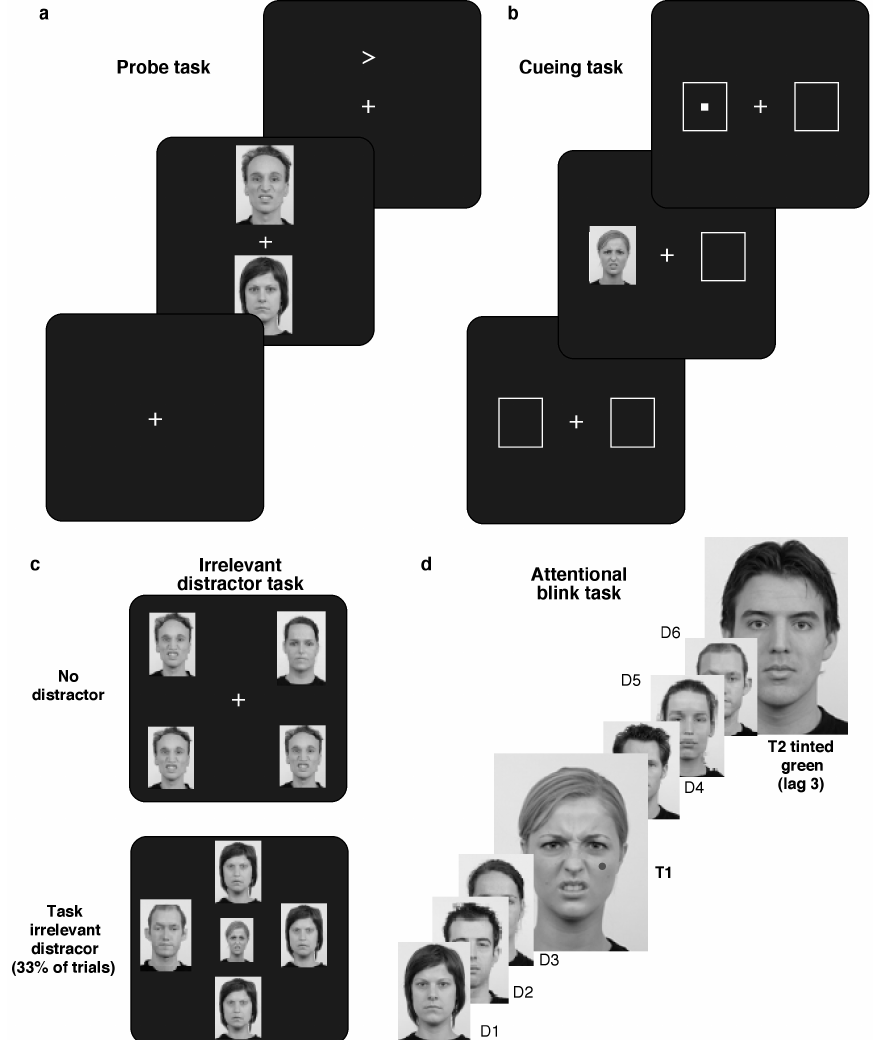
Figure 1. Experimental paradigms. ( a ) Dot-probe task : Two faces were presented for 146 ms followed by an arrow behind one of the faces ( b ) Cueing task : A face cue was presented for 146 milliseconds, immediately followed by the target at either the cued or uncued location. ( c ) Irrelevant distractor task : Participants searched for the odd face out and judged its gender while on 33% of trials a task-irrelevant face appeared at screen center ( d ) Attentional blink task : Participants had to detect the target that had a dot on either cheek (target 1, T1), and report the dot location and then judge the gender of the green tinted face (target 2, T2) that appeared 1–8 presentations later (T1 and T2 are inflated in size for demonstrative purposes only—all the images were of the same size in the